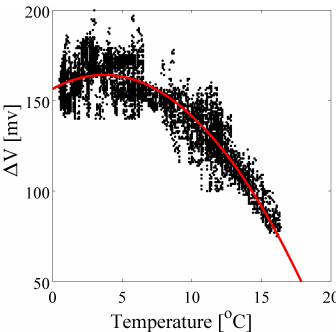
Figure 5. Second-order polynomial function fitted to the relation- ship between soil temperature and the difference between the first and second voltage